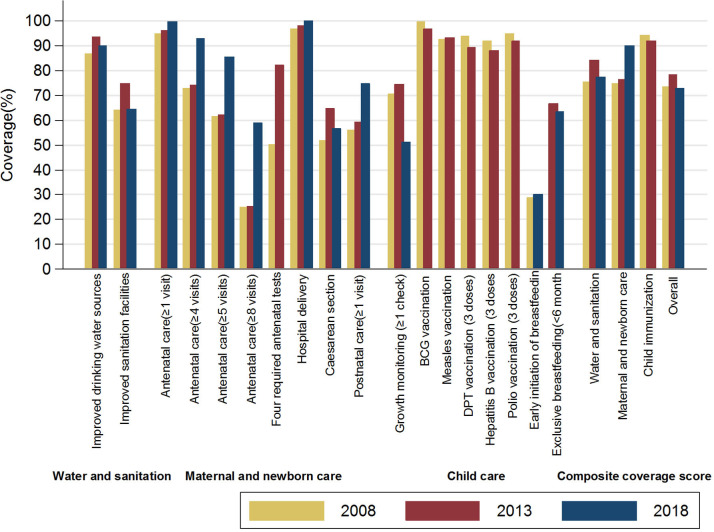
Essential MNCH intervention coverage along the care continuum, Jilin province, China (2008–2018).
Four government-funded antenatal services, defined as whether the mother received all four types of services at least once during her antenatal period. These services are freely provided by China's National Essential Public Health Services program and include blood testing, blood pressure monitoring, urine testing, and B-ultrasound examinations.Water and sanitation coverage score is the composite coverage score for improved drinking water sources and improved sanitation facilities.Maternal and newborn care coverage score is the composite coverage score for antenatal care, hospital delivery, and postnatal care.Child immunization coverage score is the composite coverage score for five types of child immunization.Overall coverage score is the composite coverage score for water and sanitation, maternal and newborn care, and child growth monitoring. Child immunization coverage scores were excluded because we lacked data in 2018.